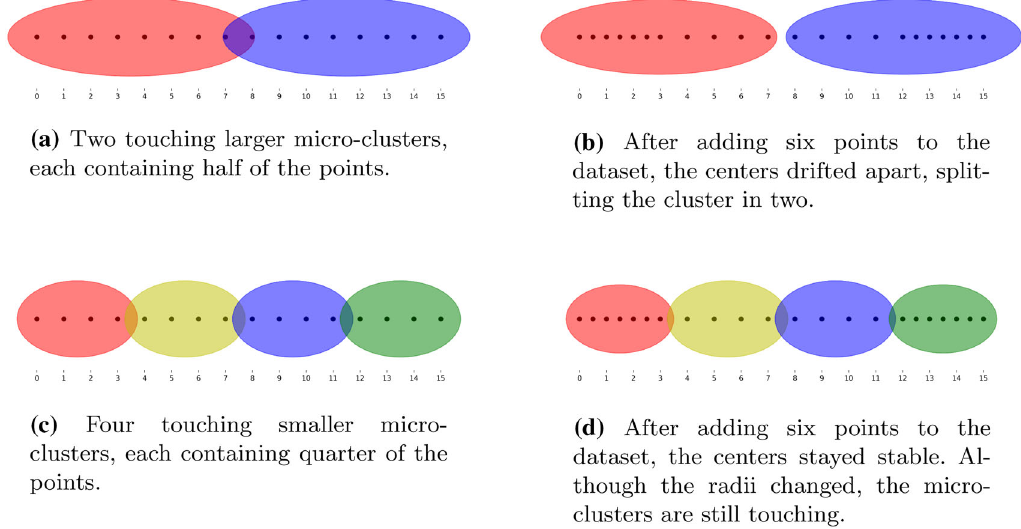
Fig. 3 A one-dimensional dataset of 16 points is clustered. Then, six points are added. The larger micro-clusters are affected such that they disconnect the main cluster. The smaller micro-clusters do not disconnect Fig. 4 Depending on the actual distribution of points, a DenStream instance using smaller micro-clusters can sometimes connect point sets, which are segmented by larger